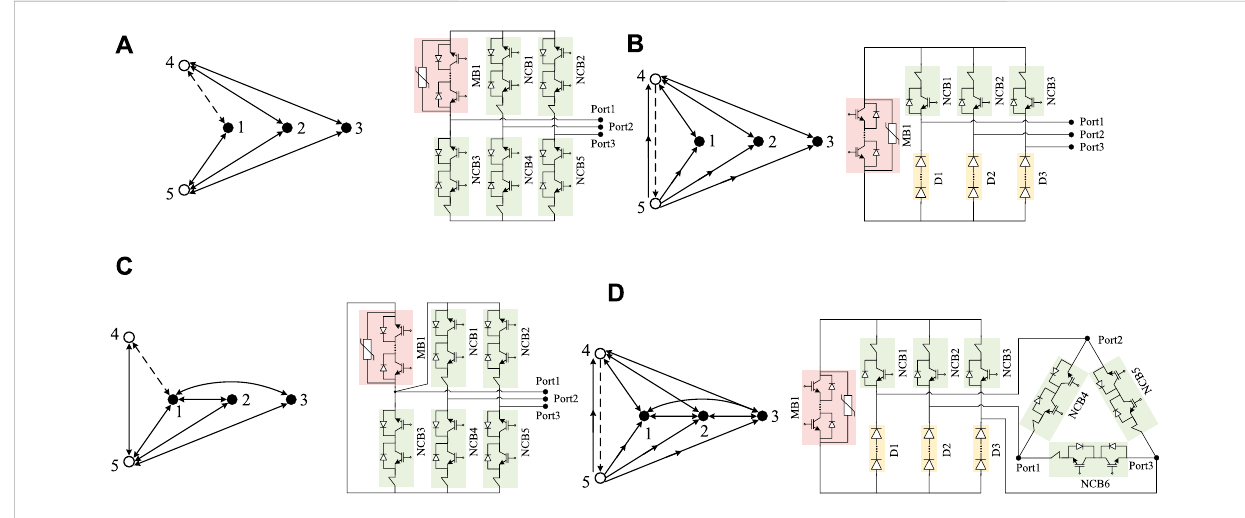
FIGURE 11 Three-portHCBtopologiessearchedbythealgorithmintwocommonconnectionpointsituations: (A) Output23,436, (B) Output39,372, (C) Output 562,813, and (D) Output 742,497.